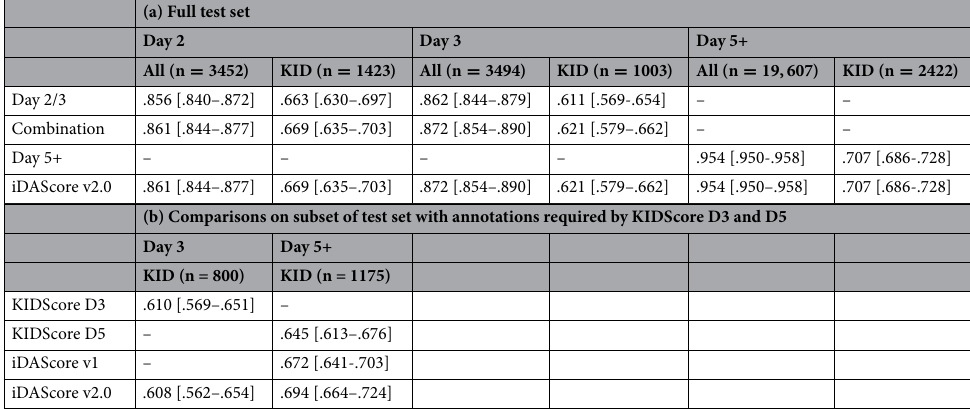
Table 2. AUCs on the test set for the different model components across days of incubation. All denotes KID+ vs. KID- plus discarded embryos, whereas KID denotes KID+ vs. KID- embryos. All AUCs are reported with 95% confidence intervals in brackets. (a) lists results on the full test set from Table 1b, whereas (b) compares performance with KIDScore D3, KIDScore D5 and iDAScore v1 models on embryos that have manual annotations available as required by KIDScore.